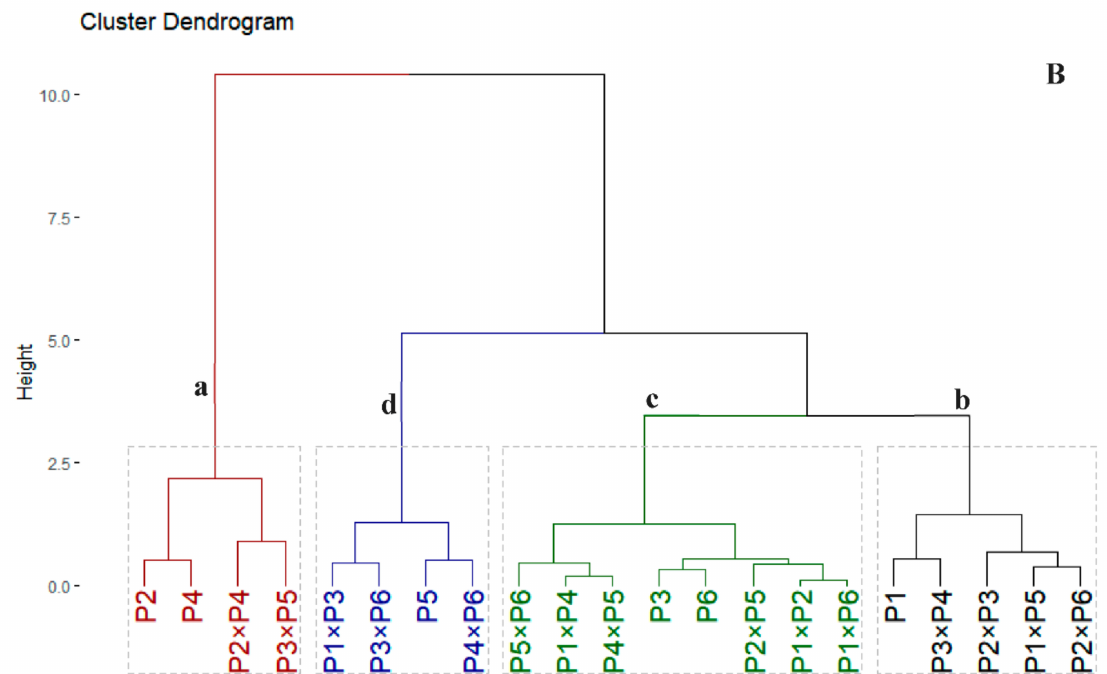
Figure 6. Dendrogram of the phenotypic distances among six wheat genotypes and their fifteen F 1s based on four heat tolerance indices (geometric mean productivity GM, mean productivity MP, and yield index YI and stress tolerance index STI). The genotypes were classified into four groups; a is heat-tolerant, b intermediate heat-tolerant, c intermediate heat- sensitive, and d is heat-sensitive under Sakha ( A ) and El-Kharga ( B ).